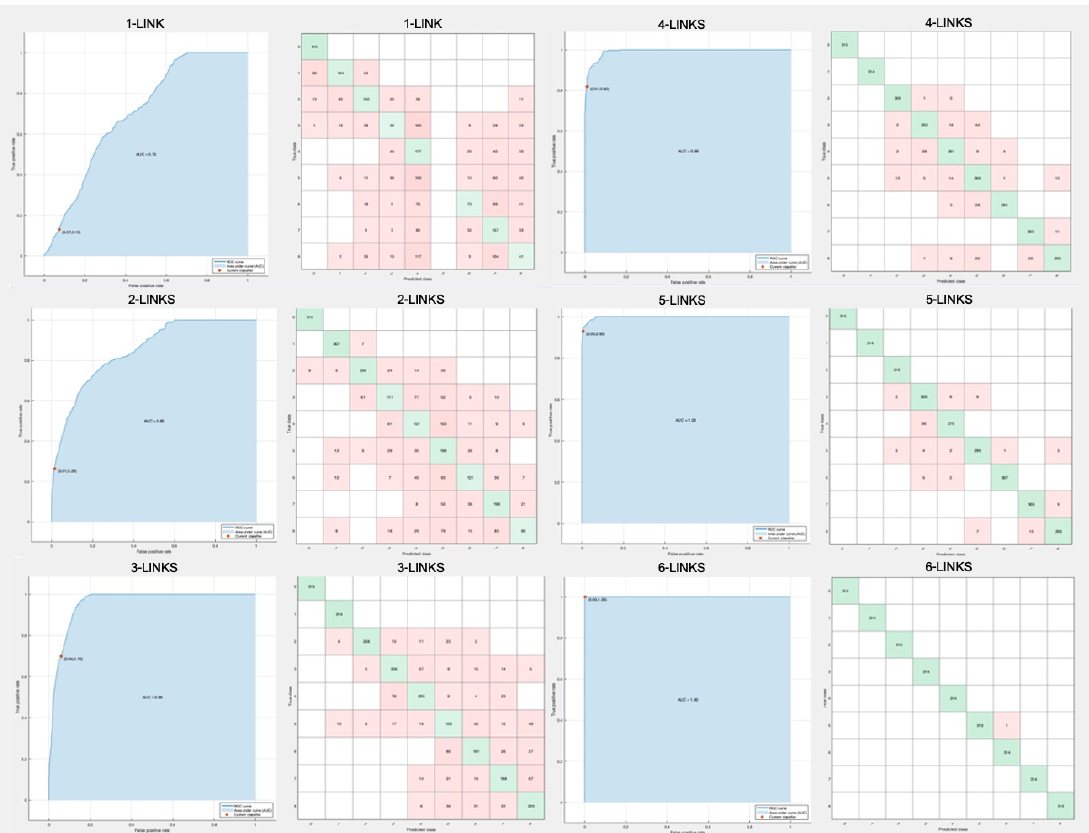
Figure 6. ROC and Confusion Matrix for incremental